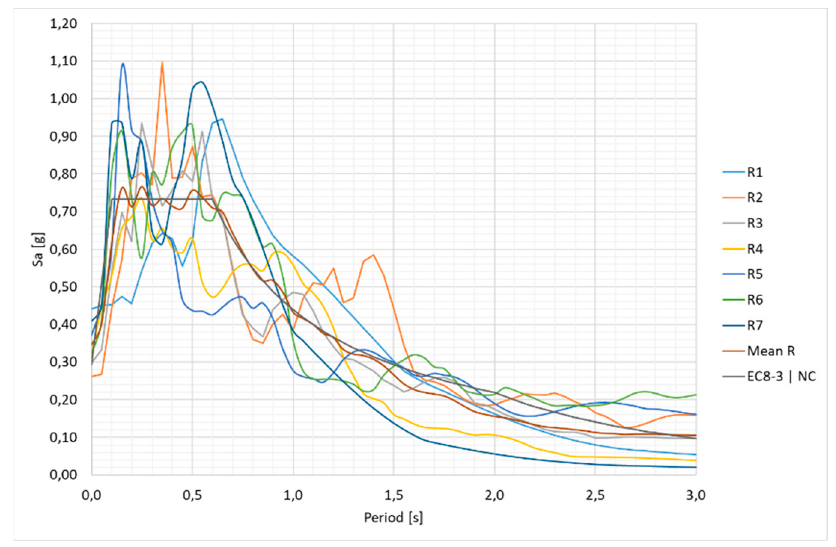
Figure 9. Ground motion records for the assessment of the EC8-3 LS of NC.